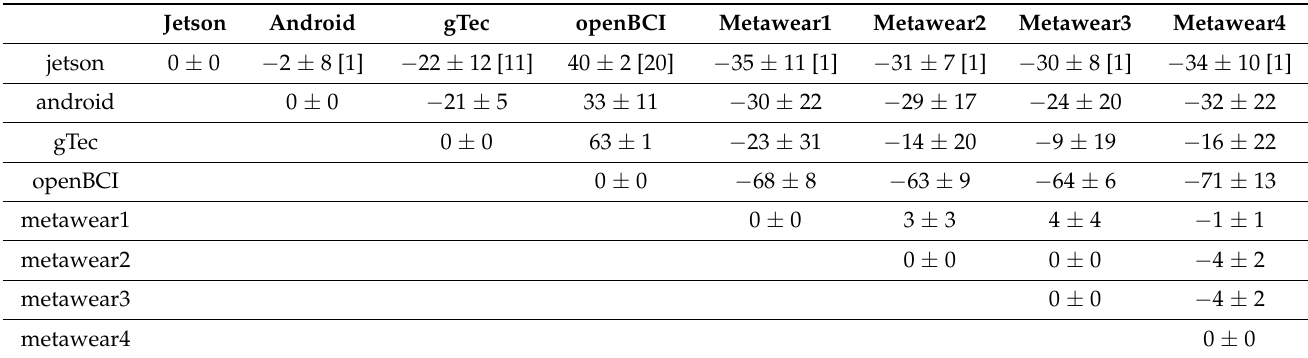
Table 1. Computed offsets (in ms) between streams (the first row contains those relative to the master IMU, i.e., the Jetson TX2 in this case) averaged across sessions. The number in [] indicates the offset in terms of samples given the different sampling